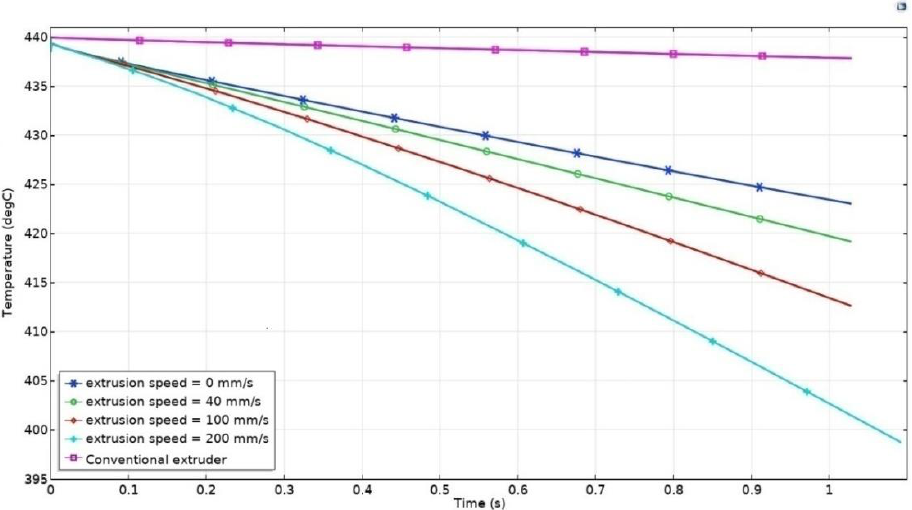
Figure 16. Cooling time curves of the induction heated (proposed)nozzle at various extrusion speeds and of the conventional hotend assembly (nozzle+heating